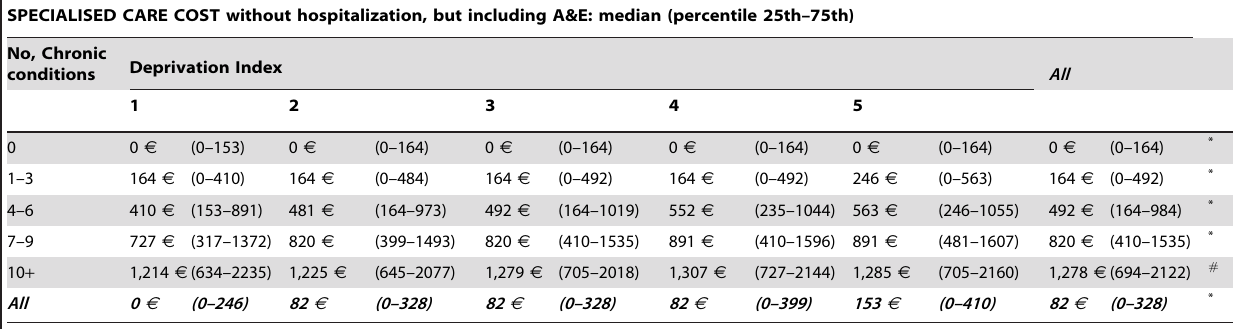
Table 4. Comparison of medians of annual specialised care costs per patient, depending on number of chronic diseases and deprivation